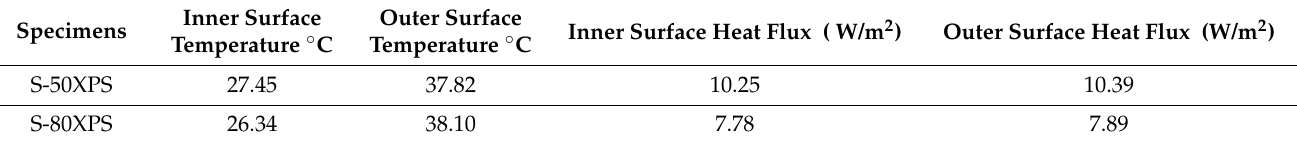
Table 3. Finite element simulation results.